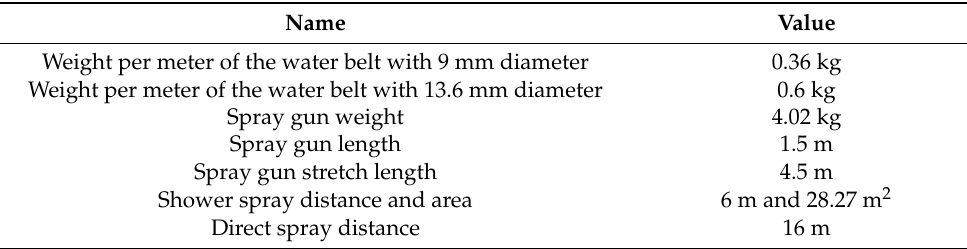
Table 2. The main performance parameters of high-pressure liquid fire extinguishing equipment.